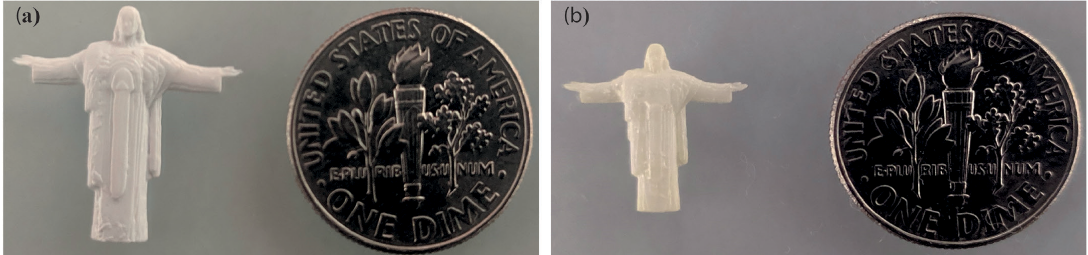
Figure 8. Printed adaptation of Christ the Redeemer Statue (Rio de Janeiro – Brazil). (a) Green part. (b) Sintered part.